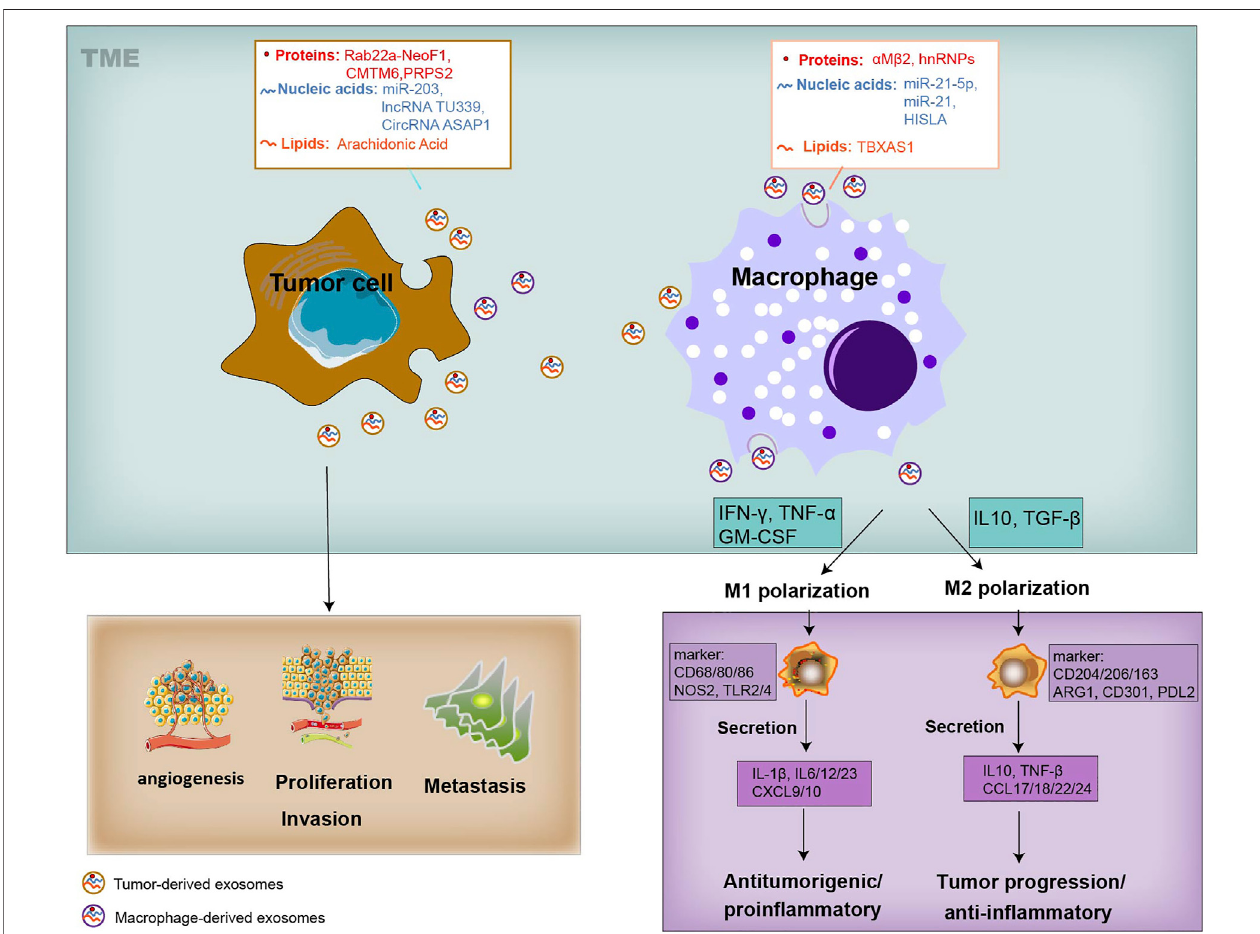
FIGURE 1 | Systematic representation of the exosome-mediated crosstalk between TAMs and tumor within the TME. Exosomes can be released by TAMs and tumor cells, and transfer information to the recipient cells. Exosomes derived from TAMs can transfer their cargo proteins ( α M β 2, hnRNPs), nucleic acids (miR-21-5p, miR-21andHISLA),andlipids(TBXAS1)toTMEbytumorcells,affectingtumorbiology,includingcellproliferation,angiogenesis,metastasis,andT-cellcytotoxicactivity. Tumorcells-derivedexosomescargoproteins(Rab22a-NeoF1,CMTM6,PRPS2),nucleicacids(miR-203,TU339andcircASAP1),andlipids(AA),andeducatethe polarization and differentiation of macrophages into the cancer-inhibiting M1 (proin fl ammatory) and cancer-promoting M2 phenotype (anti-in fl ammatory). The activation of M1 type macrophages occurs through signal transduction of IFN- γ , TNF and Toll-like receptors (TLR). M1 cells produce nitric oxide (NO), reactive oxygen species (ROS) and pro-in fl ammatory cytokines such as interleukin (IL)-1 β , IL-6, IL-12, IL-23, CXCL9, CXCL10, TNF- α , and MHC molecules. Genetic markers related to M1 polarizationincludeIL1a, IL1b,IL6,NOS2, TLR2,TLR4, CD80and CD86.Theactivation ofM2 macrophages ismediatedbyvarious cytokines. M2 cellstendtoexpress an immune suppressive phenotype, and produce anti-in fl ammatory cytokines, such as IL-10, TGF- β , CCL17, CCL18, CCL22, and CCL24. Surface proteins include CD115, CD206, PPARG, ARG1, CD163, CD301, Dectin-1, PDL2 and Fizz1.